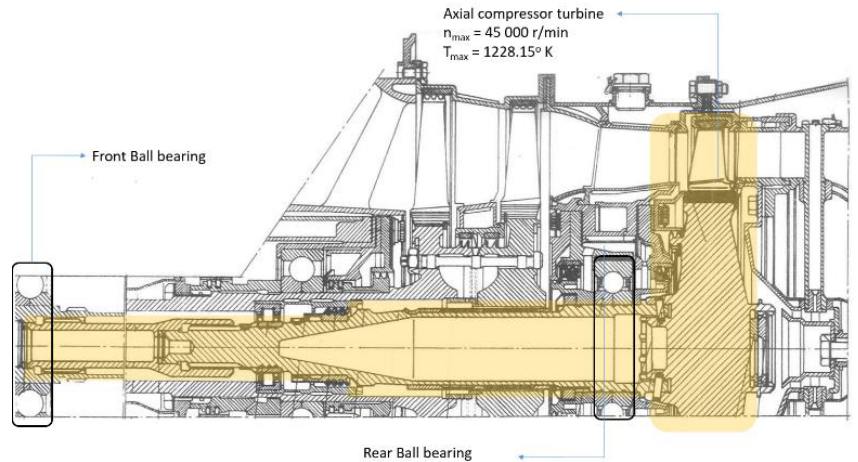
Figure 12. The GTD-350 engine, with a cross-section of the compressor turbine assembly (Adapted from [25]).